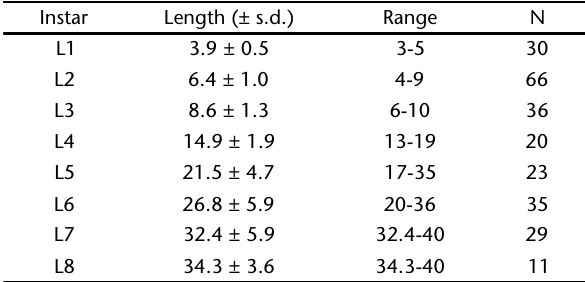
Table II. Body length (mm) of larval Altinote ozomene